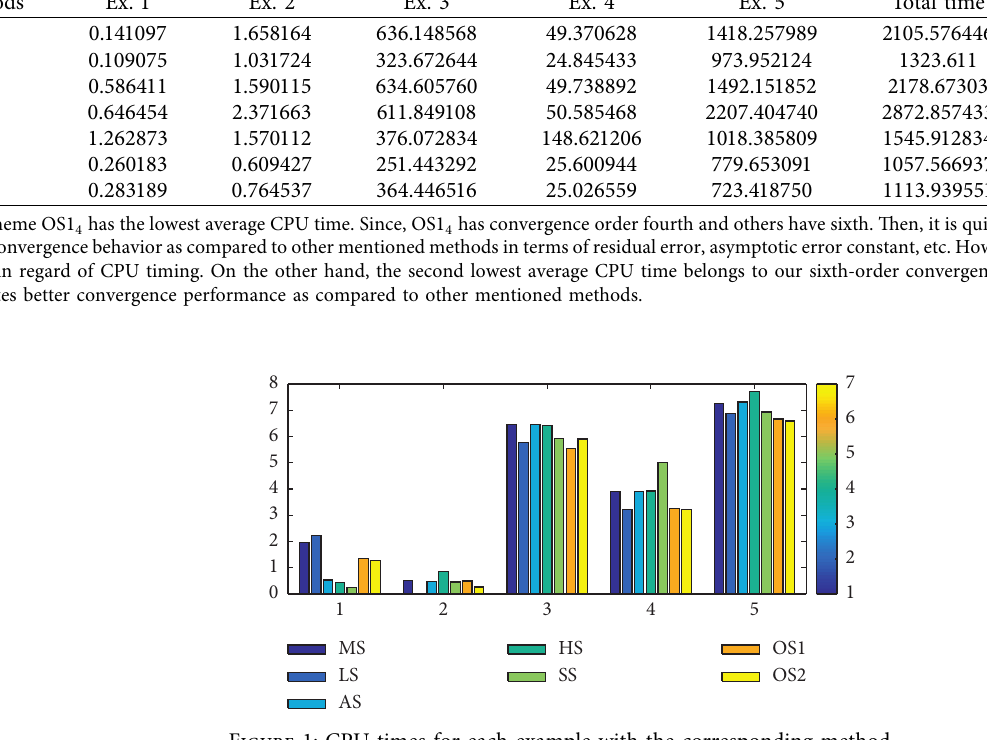
Figure 1: CPU times for each example with the corresponding